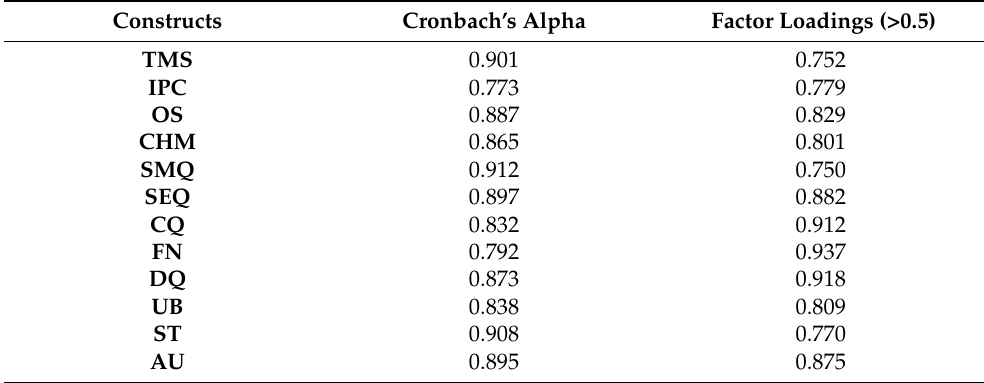
Table 3. Reliability and convergent validity